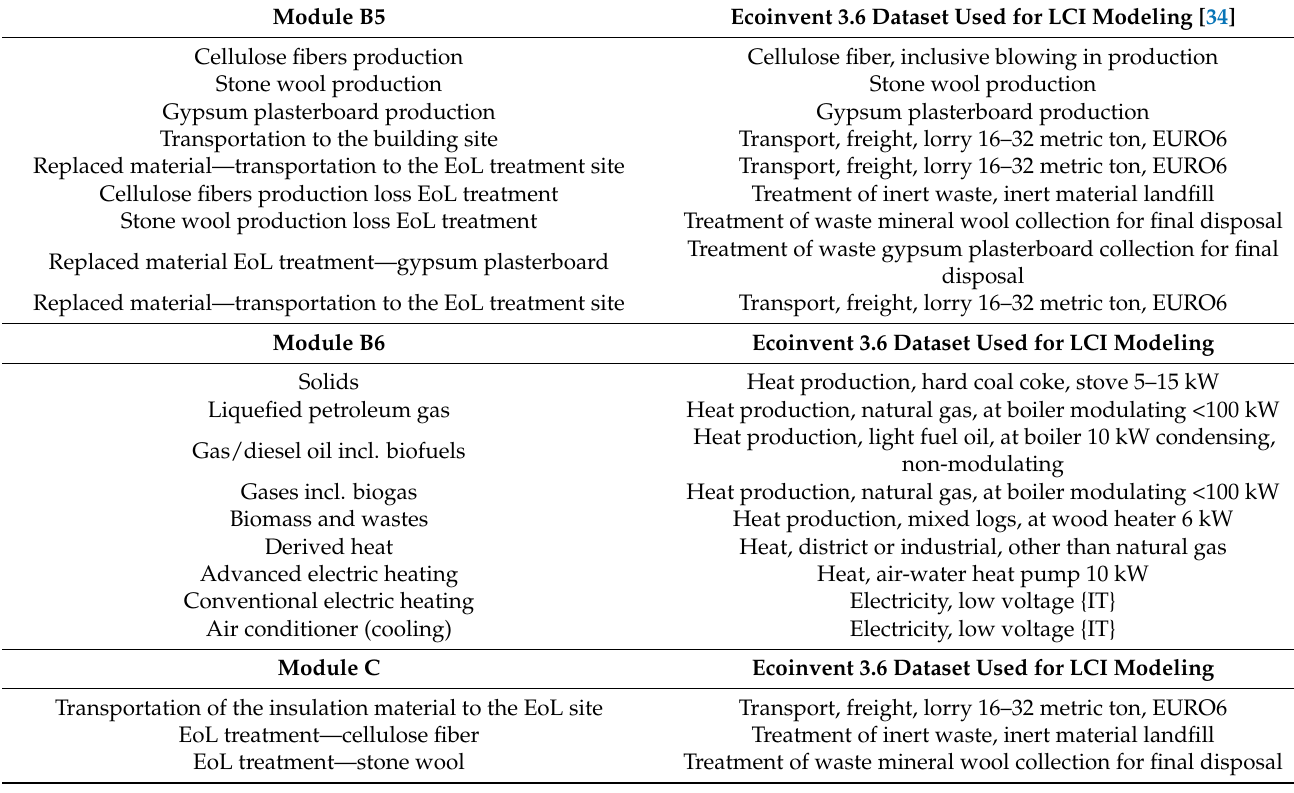
Table 3. Life cycle inventory datasets selected for life cycle phases